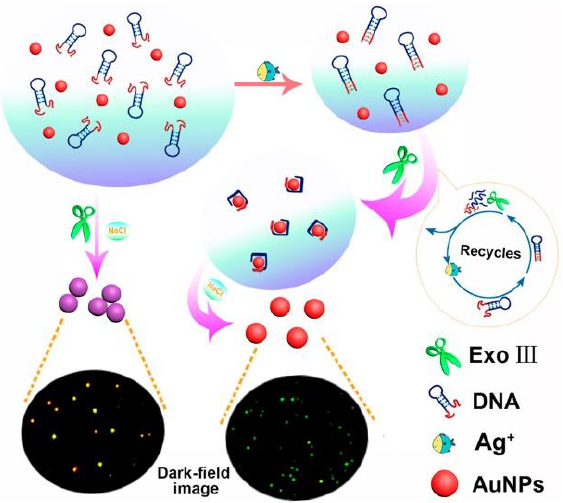
Figure 18. Scheme of DNA based Ag + sensing through Dark-Field Microscopy. Adapted with permission from Li et al. [80] (Copyright © (2018) ACS.